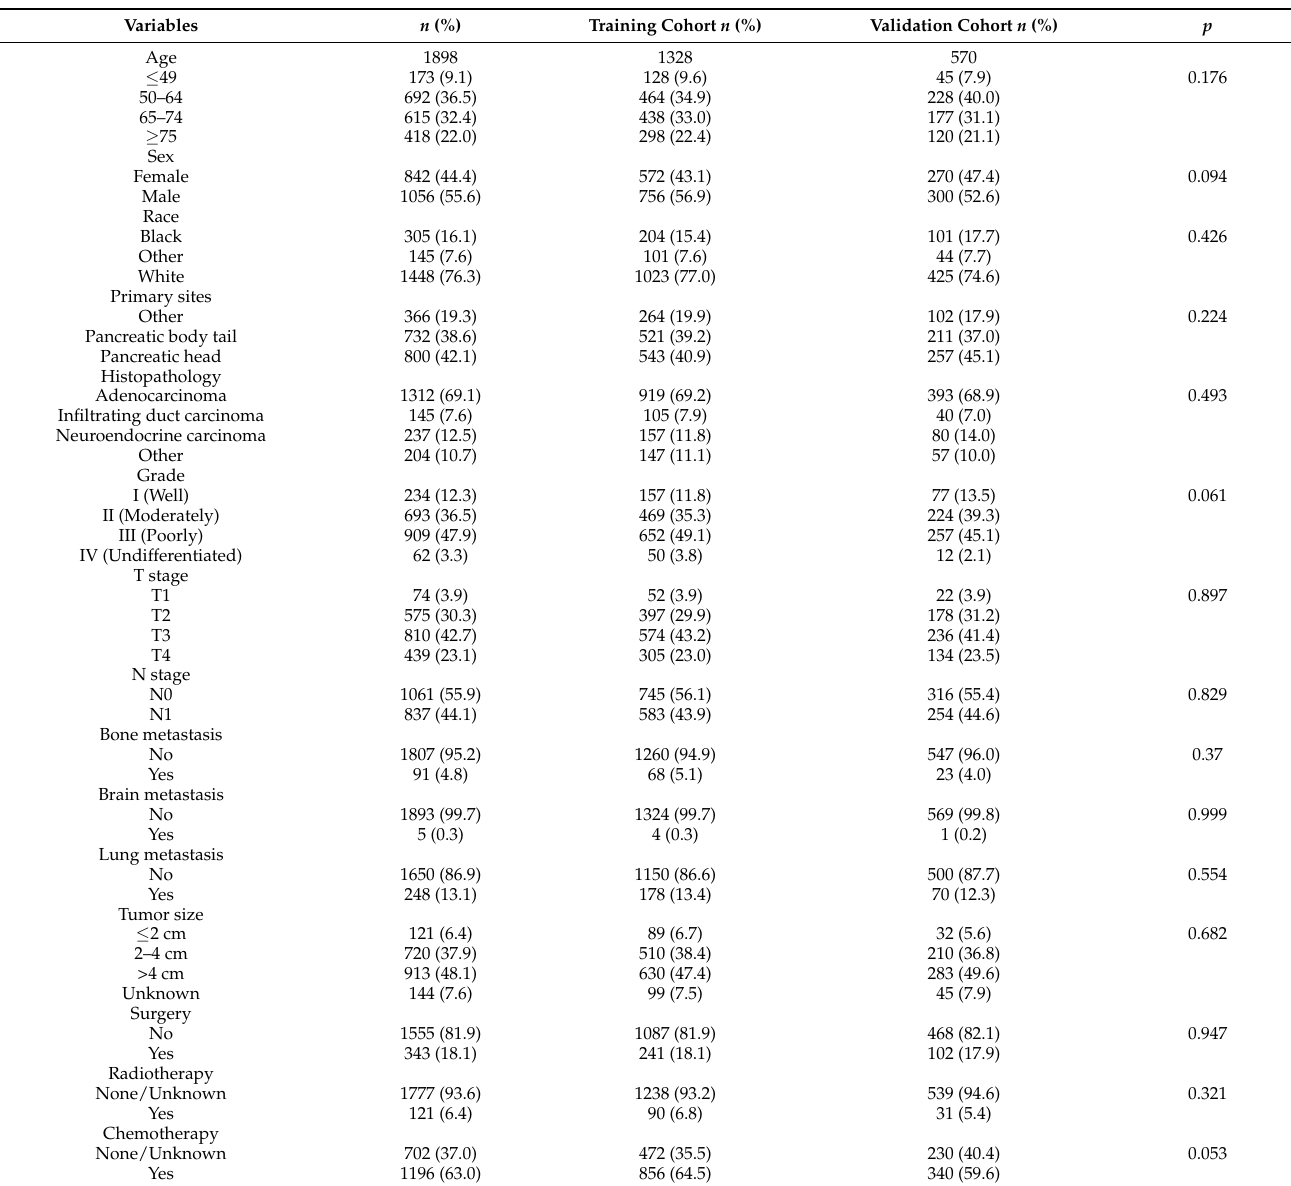
Table 3. Demographic and clinicopathologic characteristics of 1898 patients of pancreatic cancer with liver